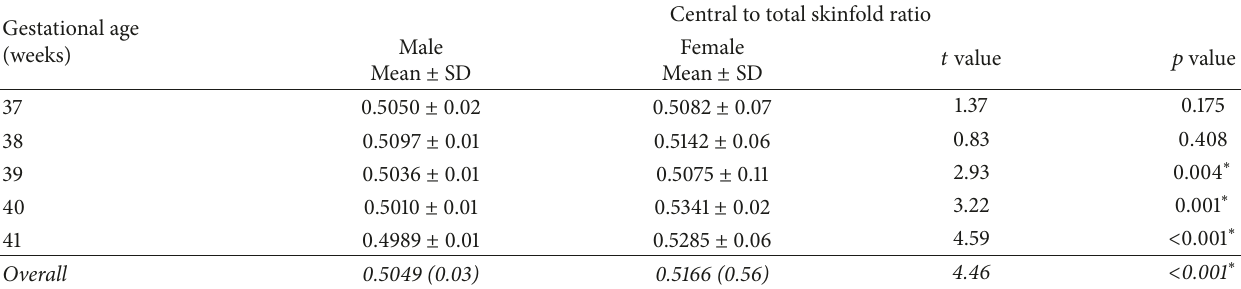
Table 4: The central to total skinfold ratio according to gender and gestational